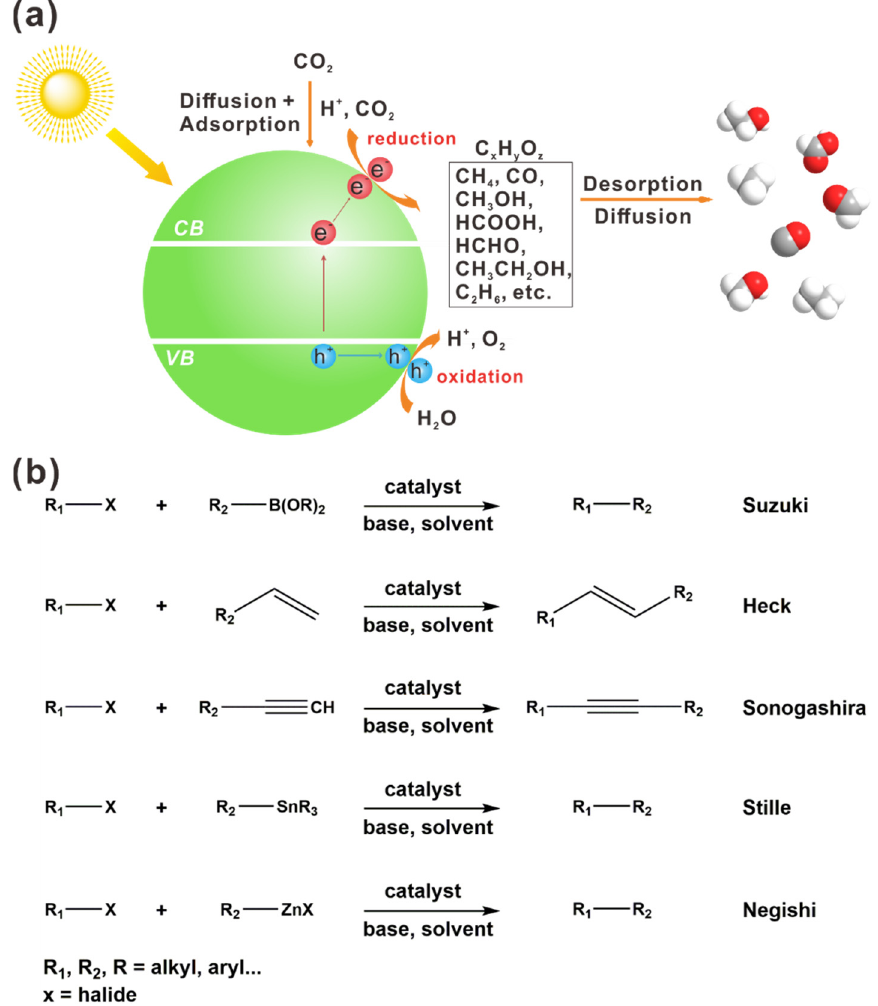
Figure 1. The carbon–carbon coupling reactions. ( a ) The general process of CO 2 reduction in a photocatalytic system inspired by photosynthesis and ( b ) the summary of carbon–carbon cross-coupling in organic chemistry.